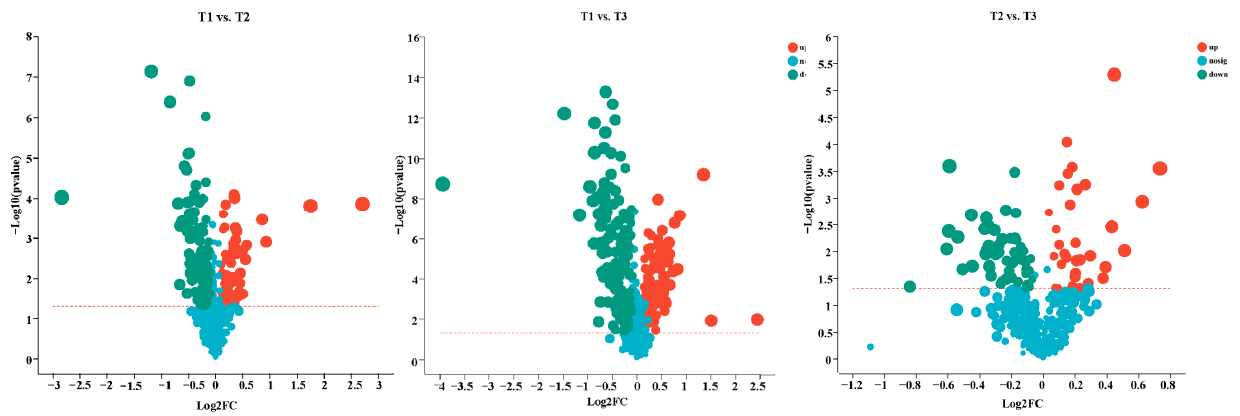
(map00908), starch and sucrose metabolism (map00500), plant hormone signal transduction (map04075), and phenylpropanoid biosynthesis pathways (map00940) (Figure 8C).